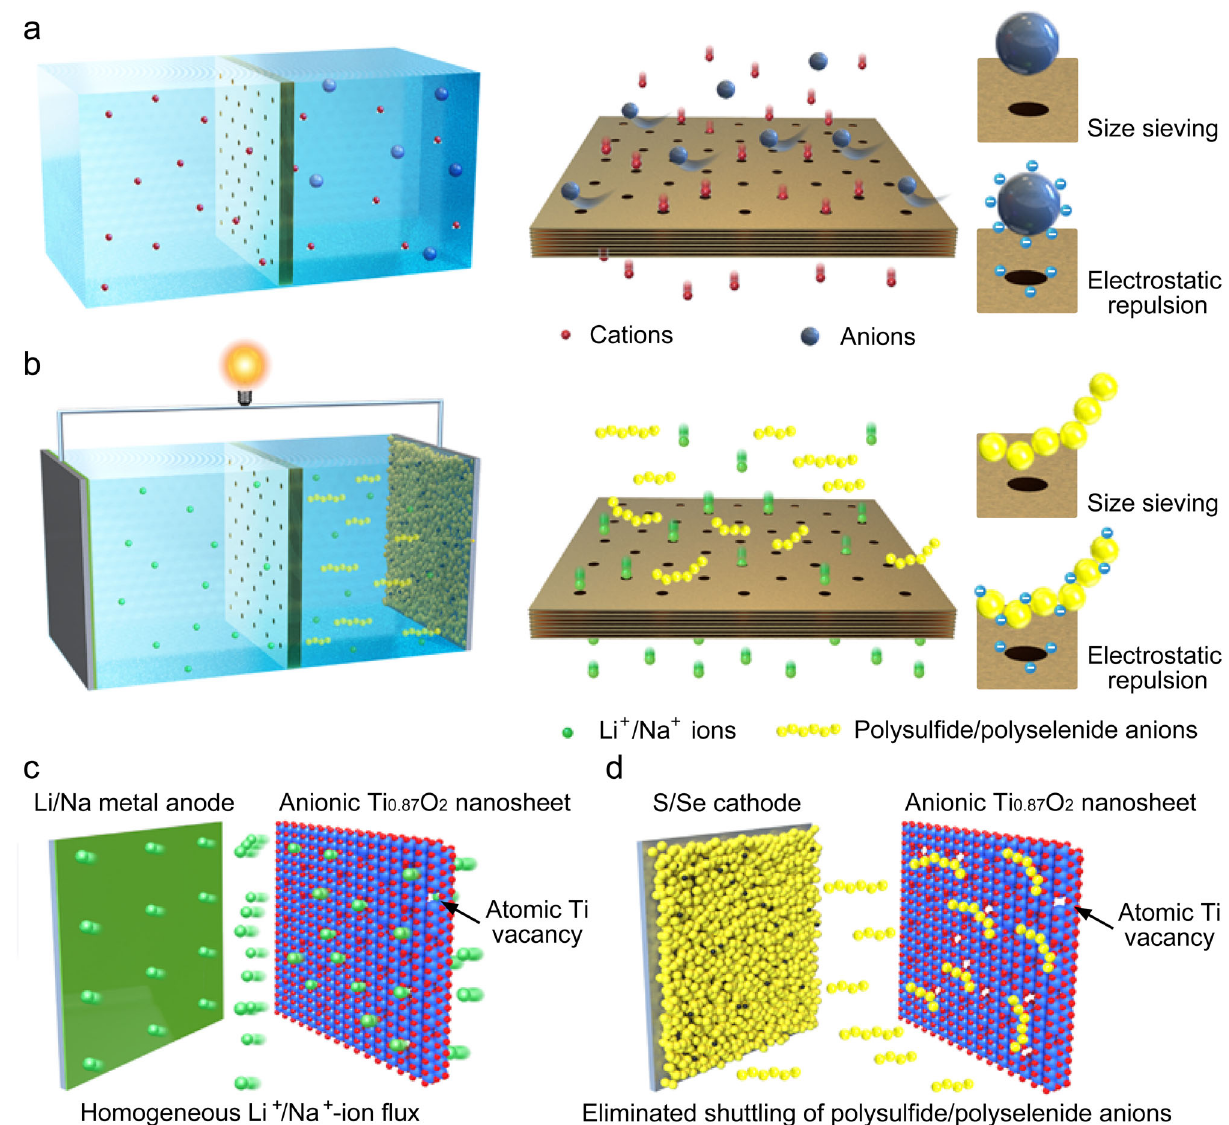
Fig. 1 Schematic illustration of 2D porous nanosheets as a selective ionic sieve in membrane-based separation and alkali metal-S/Se batteries. a 2D porous nanosheet-based membranes act as selective ionic sieves in membrane-based separation technologies. The small cations can pass, while large anions are selectively excluded based on a size-sieving effect and electrical interaction between ions and membrane. b 2D nanosheets with sub-nanometer pores act as selective ionic sieves in alkali metal-S/Se batteries. The small Li + /Na + ions can rapidly pass through the sub-nanopores, while the large polysul fi de/polyselenide (PS) anions are selectively excluded due to size-sieving effect and electrical repulsion between PS anions and negatively charged nanosheets. c 2D negatively charged Ti 0.87 O 2 nanosheets with atomic Ti vacancies offer strong electrostatic interaction with Li + /Na + ions, resulting